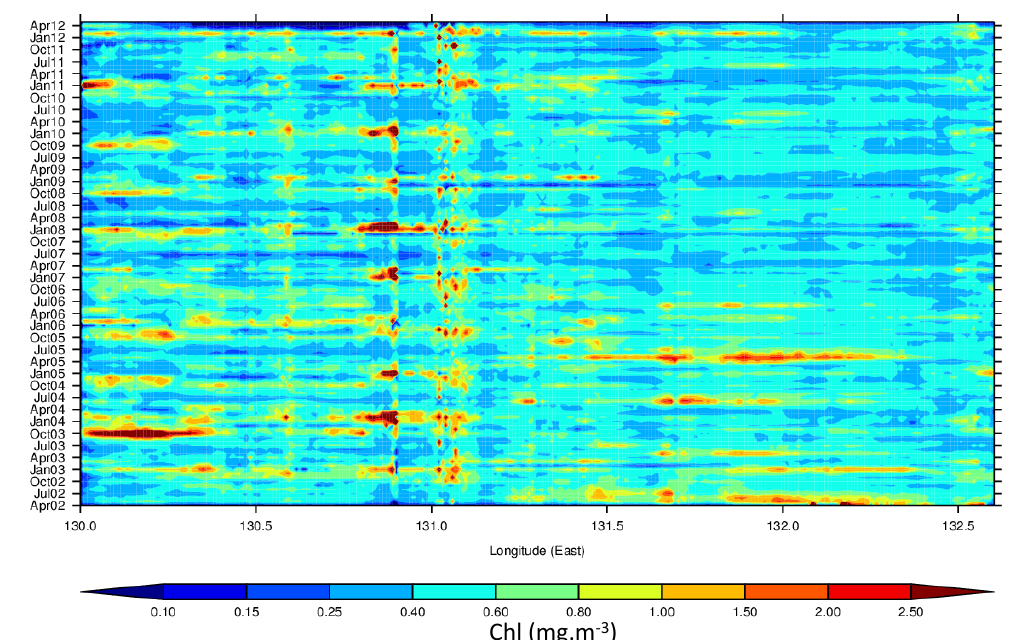
Figure 19. Longitude-time plot of Chl for the VDG